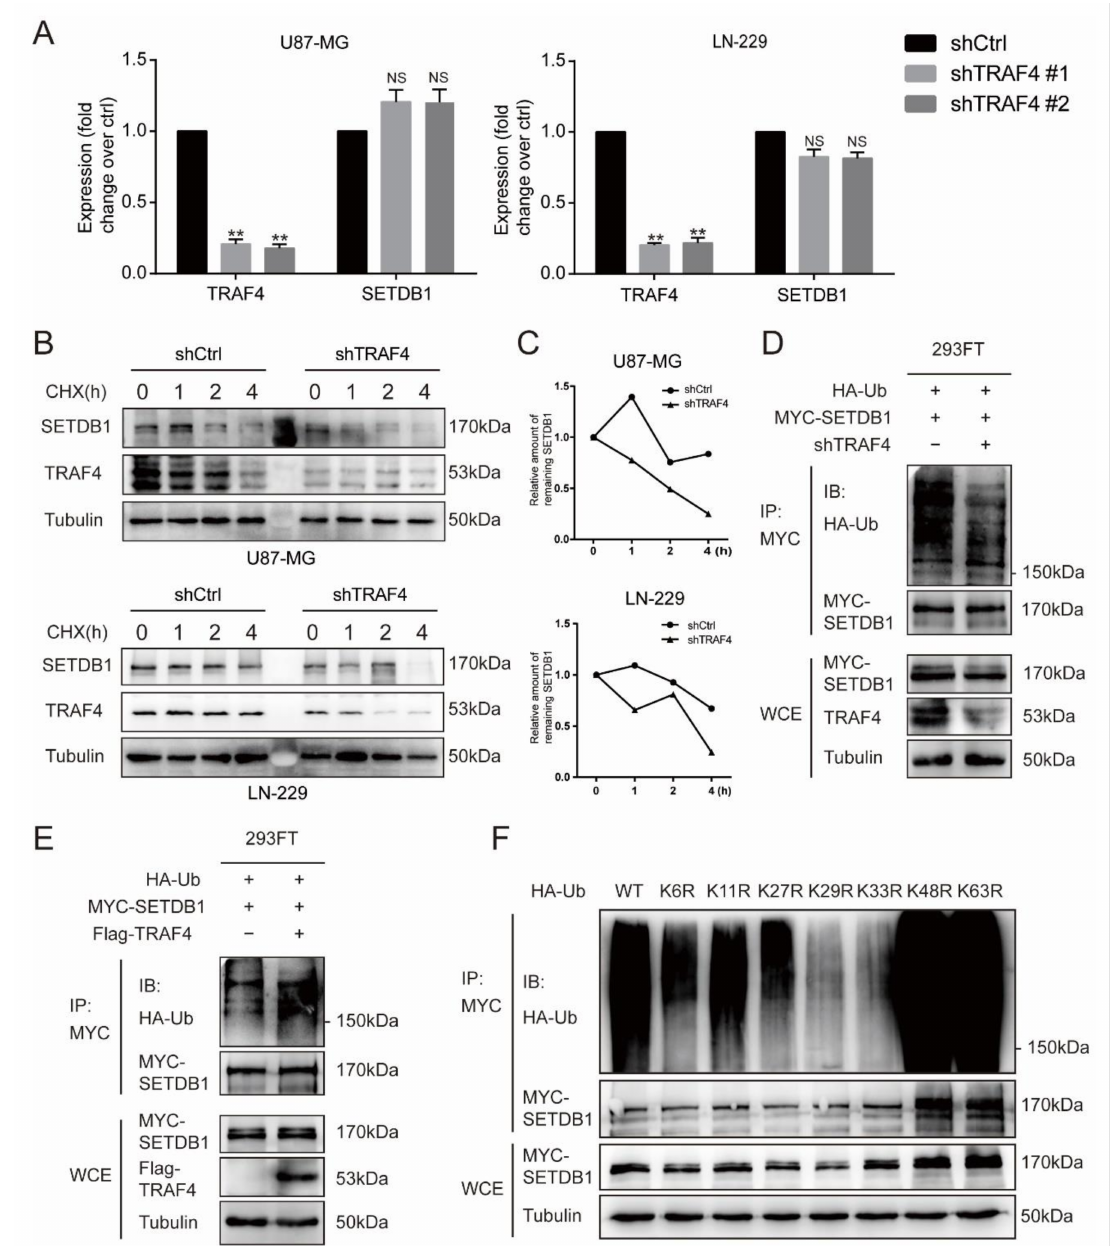
Figure 6. TRAF4 regulates SETDB1 stabilization and mediates atypical ubiquitination of SETDB1. ( A ) TRAF4 and SETDB1 mRNA levels were examined by qRT-PCR in glioblastoma cells. ( B , C ) Control group and TRAF4 knockdown cells were treated with CHX in a time gradient (0 h, 1 h, 2 h, 4 h). The protein expression of SETDB1 was detected by Western blot. The grey values were calculated by ImageJ. ( D , E ) MYC-tagged SETDB1, HA-tagged Ub, and ( D ) shTRAF4/ ( E ) Flag-tagged TRAF4 constructs were cotransfected into 293FT cells. The ubiquitinated SETDB1 proteins were pulled down with anti-MYC antibody and immunoblotted with anti-HA antibody. ( F ) The Flag-tagged TRAF4, MYC-tagged SETDB1, HA-tagged Ub, and ubiquitin mutant constructs were cotransfected into 293FT cells. The 293FT cells were treated with MG132 for ubiquitination assays. Student’s t test was performed to analyze significance; ** p < 0.01, NS: not